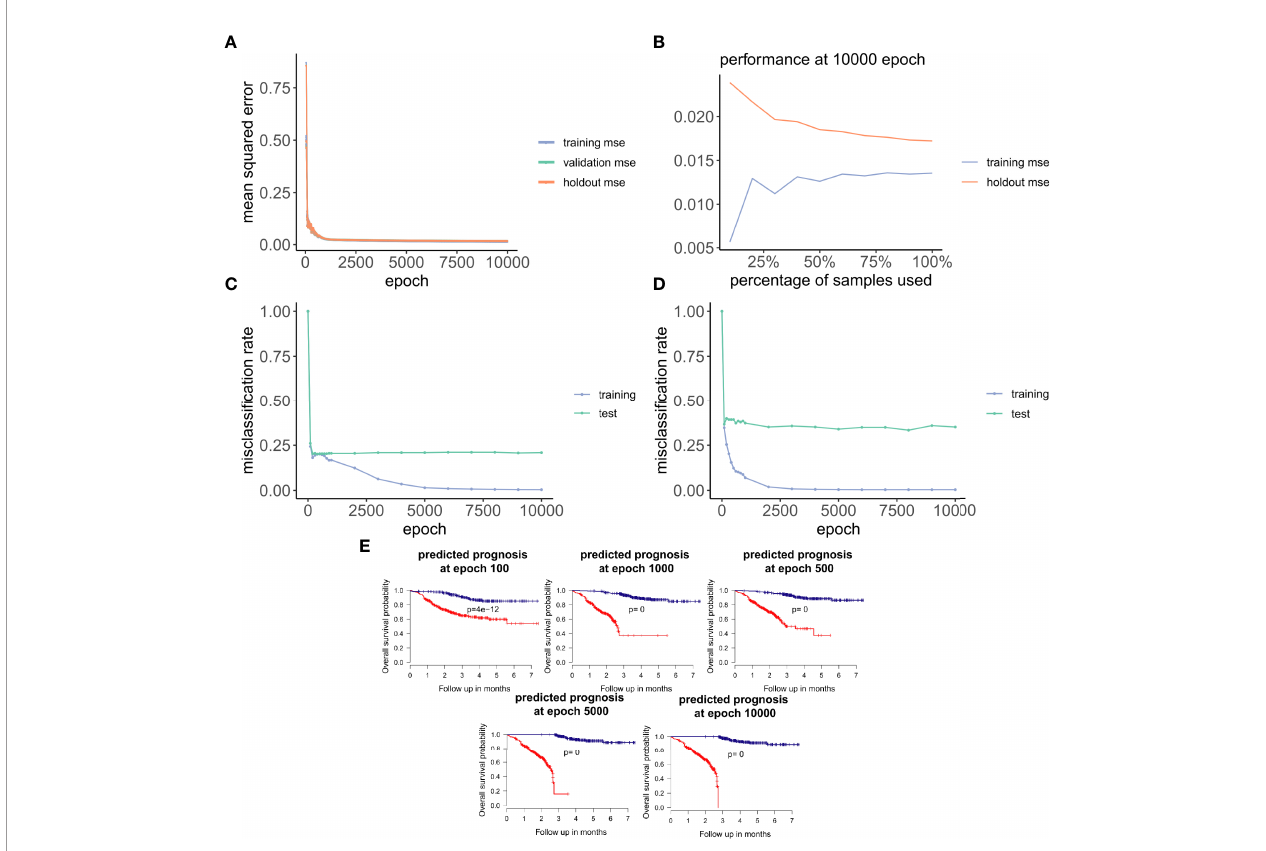
FIGURE 3 | ANNE model training and evaluation for models trained with a linear activation function. (A) Training curve showing the loss function of mean-squared-error (MSE) with epochs during training, validation (10-fold cross-validation), and holdout (excluded 10% of the data) sets with a linear activation function. (B) Change of performance for training and holdout sets with 10000 training epochs and by varying batch size. During model validation MSE improves as more samples are used for training, indicating that the model is learning from its input gaining information which can be extended to unknown samples. (C, D) Performance class prediction (misclassi fi cation rates) for chemo- sensitive and resistant (pCR and RD) and prognosis (good and poor) models improves with epochs trained. (E) Kaplan-Meier overall survival plots for poor and good breast cancer prognosis groups at different epochs trained. (100, 500, 1000,